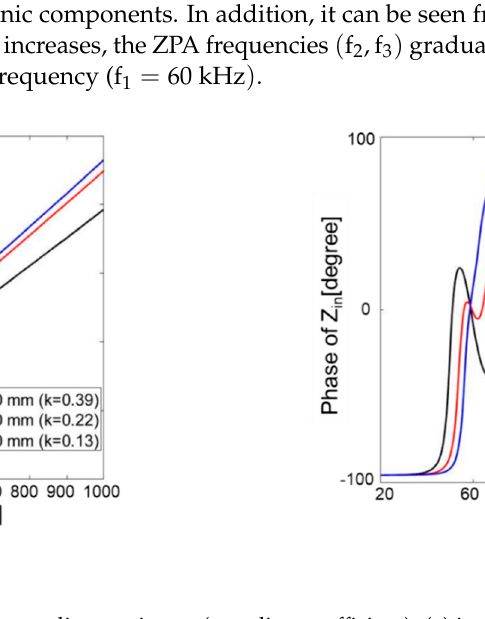
Figure 22. Measured input impedance according to air gap (coupling coefficient): ( a ) input impedance magnitude change according to frequency change; ( b ) input impedance phase change according to frequency change.